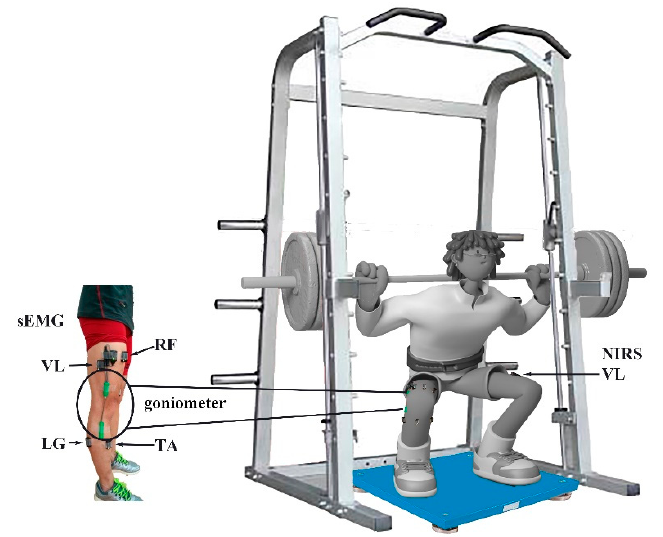
Figure 1. Experimental setup and the instrumentation used during the 30% 1 RM loaded CMJ jump. sEMG sensors were attached to 9 lower muscles and an SG 150 goniometer was placed on the right side; a NIRS sensor was attached to the VL on the left side, and a force plate was placed under the athlete’s feet.